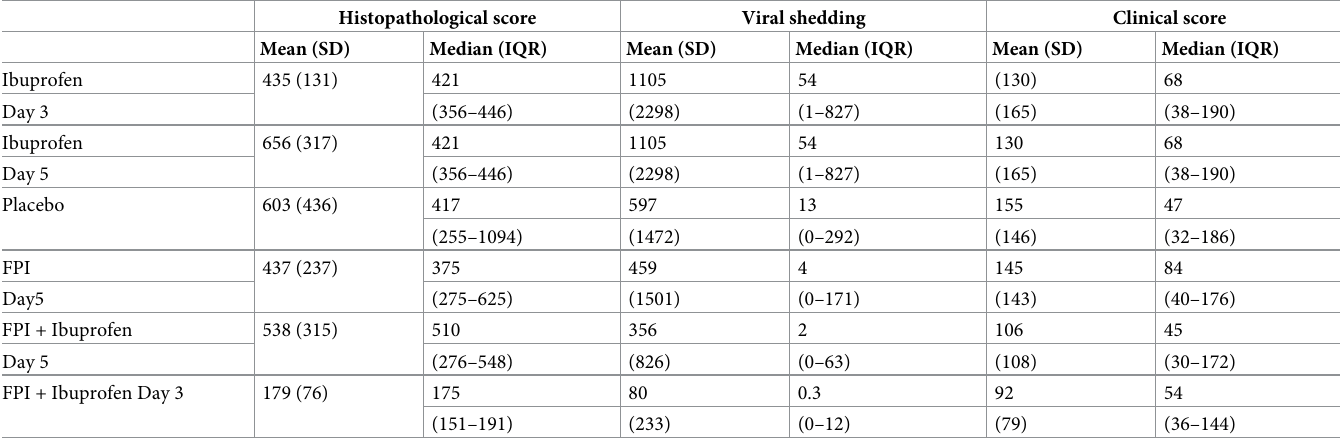
Table 3. Mean and median scores for each variable.